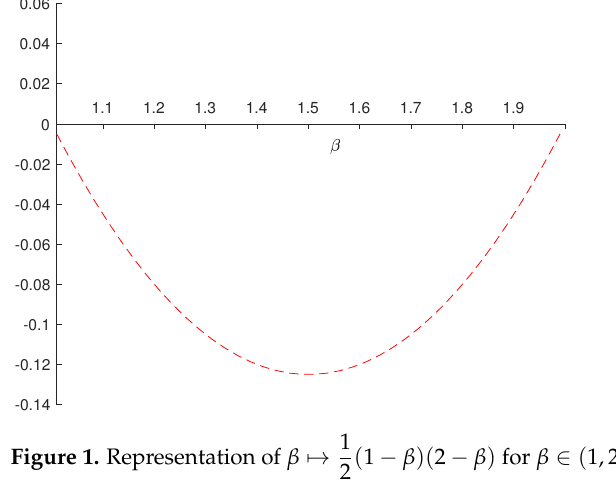
Figure 1. Representation of β (cid:55)→